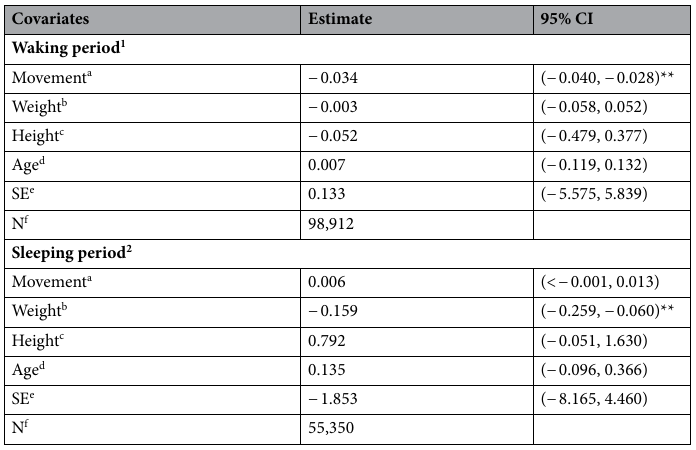
Table 3. Relationships of movement, weight, height, age, sleep efficiency with glucose rate of change (%) in pregnancy in stratified analyses by waking period and sleeping period (95% CI). Regression coefficients are given by the 1st quartile unit increases for movement, weight, height, age and sleep efficiency. The 1 st quartiles: Movement (waking period) = 3.6 mg . Movement (sleeping period) = 0.1 mg . Weight = 66 kg. Height = 1.63 m. Age = 27.9 years. Sleep efficiency = 88%. Linear mixed effects models stratified for waking period 1 and sleeping period 2 : a Movement ( mg ), b Weight (kg), c Height (m), d Age (years), e Sleep efficiency (%). f Number of observations. **Statistically significant results.